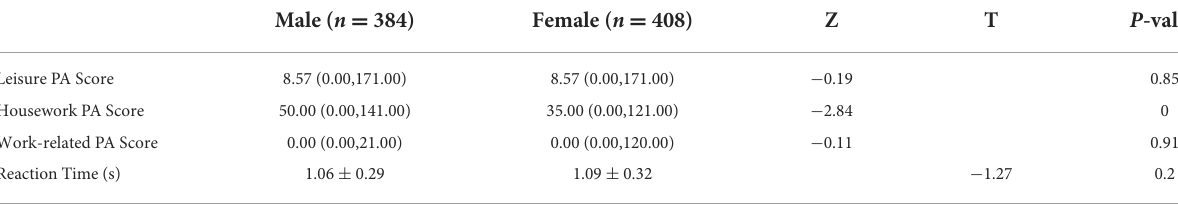
TABLE 3 Comparison of PASE score and reaction time in participants of different